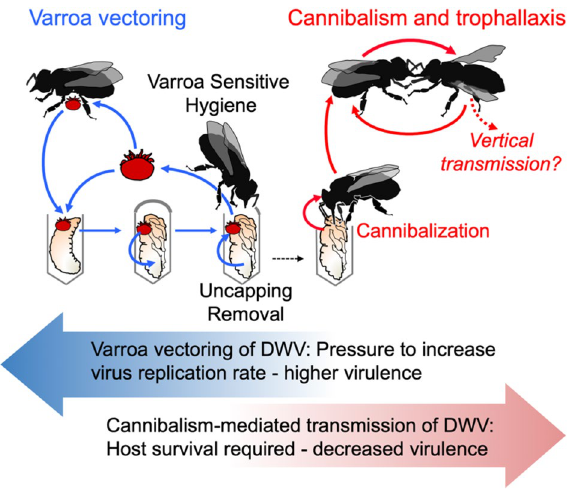
Figure 6. Model of DWV circulation in Varroa mite-infested Varroa Sensitive Hygienic (VSH) colonies. Varroa transmission—blue arrows, cannibalism-trophallaxis transmission—red arrows. Block arrows show possible evolutionary pressures which on Varroa and cannibalism-trophallaxis transmission routes impose on DWV